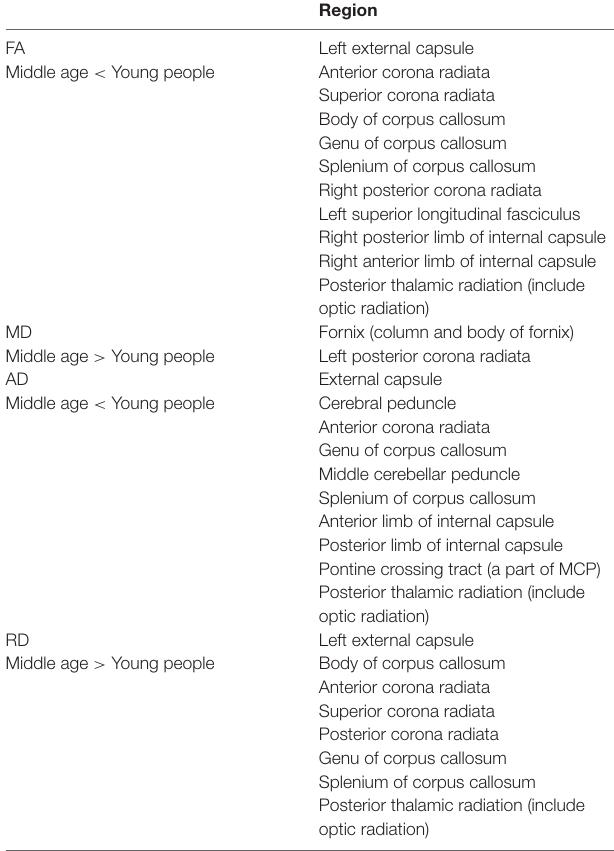
TABLE 2 | The TBSS results were obtained by age